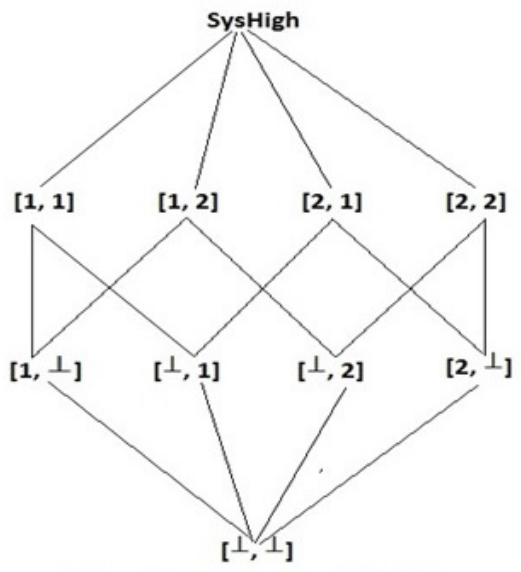
Figure 9. Chinese Lattice